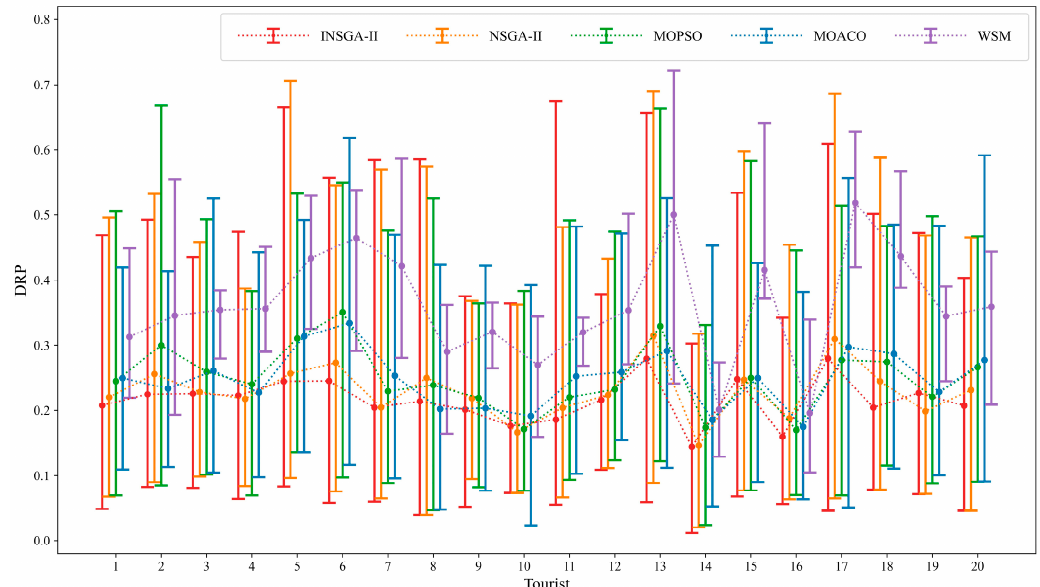
Figure 12. The final non-dominated solutions from different methods (an example of tourist #12).